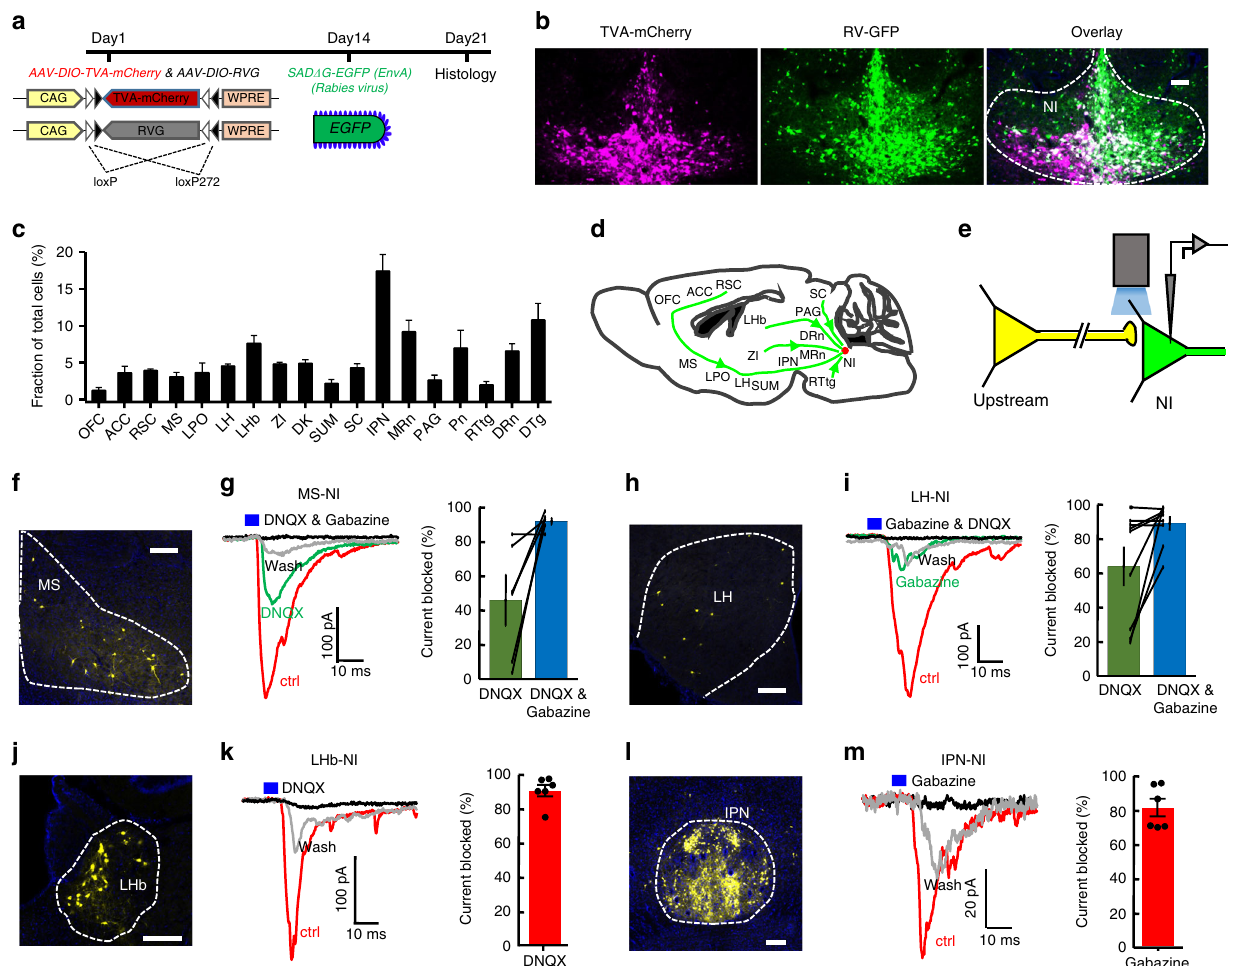
Fig. 5 NI NMB neurons receive inputs from brain areas associated with arousal and locomotion. a The strategy for monosynaptic retrograde tracing of NI NMB neurons. b The expression pattern of TVA-mCherry (red) and RV-GFP (green) at the injection site within the NI. Dual labeled cells indicate starter cells competent for retrograde transsynaptic traversal. c Ratio of total retrogradely-labeled neurons in various upstream stations of NI NMB neurons ( n = 4 mice). d Schematic showing the inputs of NI NMB neurons. e Schematic diagram showing terminal photostimulation of the upstream neurons and whole- cell patch recording of the NI NMB + cells. f Presynaptic RV + cells in the MS. g Postsynaptic responses from a NMB + neuron in the NI following photostimulation of ChR2 + MS neuron axonal terminals under the conditions of control (latency, 8.1 ± 0.8 ms), drug applications, and wash. Postsynaptic current was measured holding at − 65 mV. The right panel shows the summary effect of DNQX and the addition of Gabazine ( n = 6 NMB + cells from 2 mice). h , i Presynaptic RV + cells in the LH ( h ) and the physiological effect of photostimulating ChR2-expressing LH axonal terminals on NI NMB neurons ( i ; latency, 6.6 ± 0.6 ms). Right panel in ( i ) shows the drug effects ( n = 9 NMB + cells from 2 mice). j , k Presynaptic RV + cells in the LHb ( j ) and the physiological effect of activating LHb axonal terminals on NI NMB neurons ( k ; latency, 8.5 ± 1.0 ms; n = 6 NMB + cells from 2 mice). l , m Presynaptic RV + cells in the IPN ( l ) and the physiological effect of activating IPN axonal terminals on NI NMB neurons ( m ; latency, 6.2 ± 1.2 ms; n = 6 NMB + cells from 2 mice). Error bars ( c , g , i , k , m ) indicate SEM. Scale bars = 200 µ m ( b , f , h , j , and l ). Source data are provided as a Source Data fi le. Projection targets of NI NMB neurons . We next explored how NI NMB neurons functionally regulate the activity of downstream neurons. Labeling with mCherry and in situ hybridization map- ping of mRNA transcripts for the vesicular GABA transporter ( Vgat ) revealed that ~76% of NMB neurons are apparently